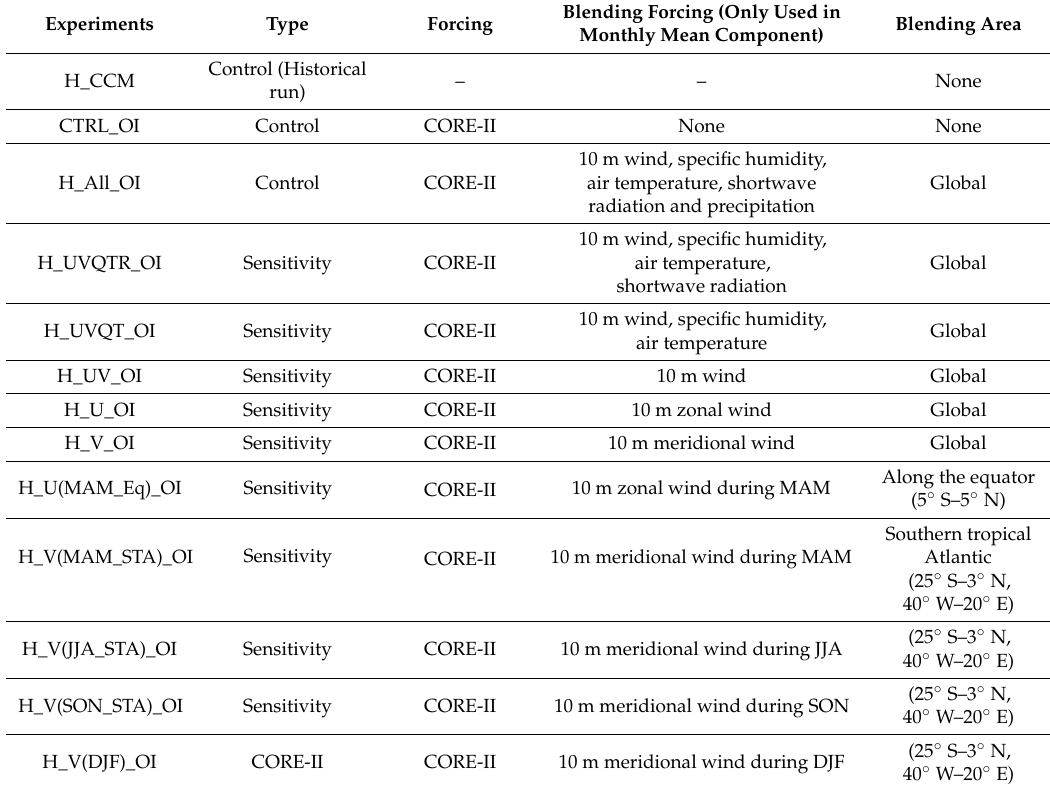
Table 3. Experiments based on the ocean-ice model